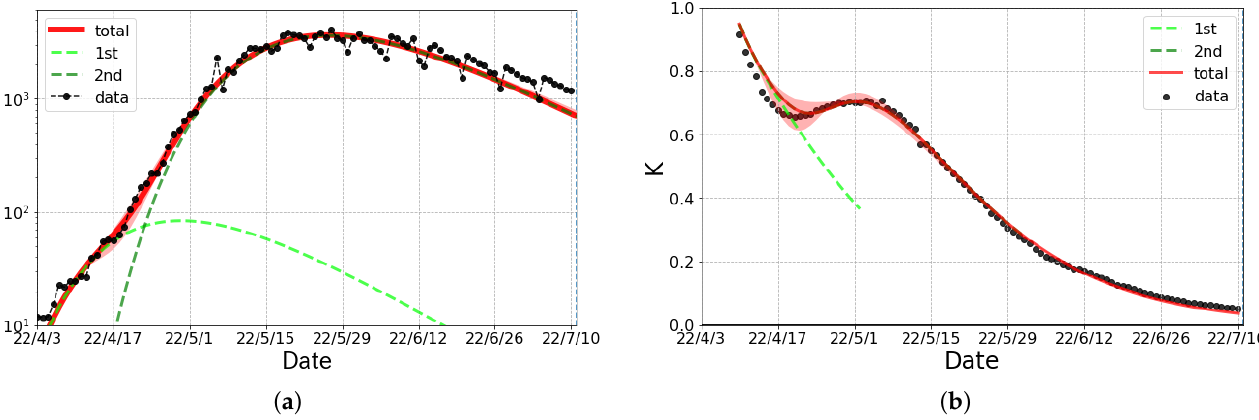
Figure 2. The logarithmic plot of the epicurve for the Omicron surge in COVID-19 in Taiwan from April to July 2022. ( a ) The reported cases per million and fitted results (solid curve). The fit was performed with two partial waves denoted by dashed lines. ( b ) The observed data and fitted results of the K-value. The red bands stand for the systematic errors in the choice of the fitted range of the first and second partial wave. Table 2. The parameters of the Gompertz curves in the Omicron surge in Taiwan. The definition of the parameters is the same as in Table 1, but the reference date is 3 April 2022. Partial Wave N ∞ per Million R